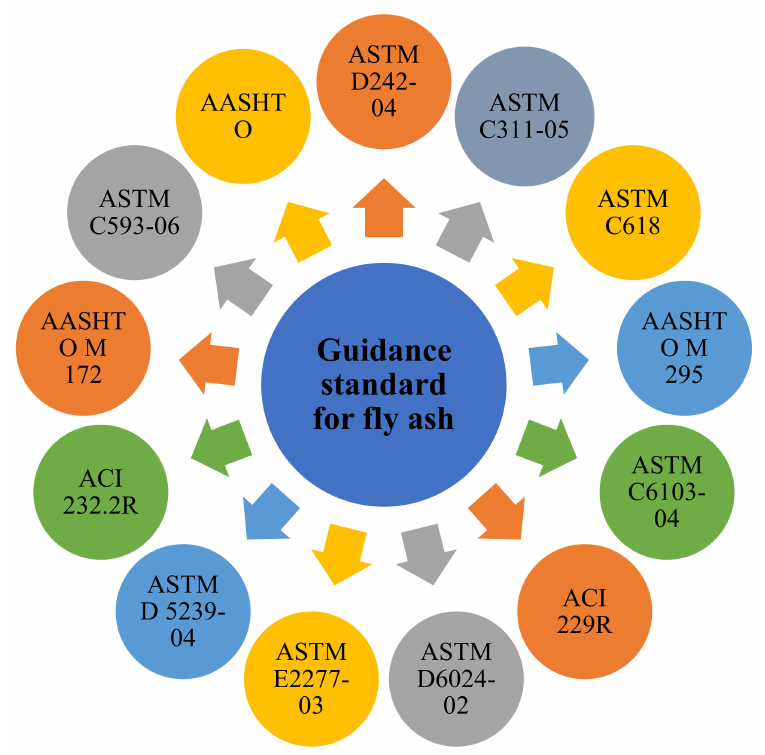
Figure 8. Guidance standards used for FA quality